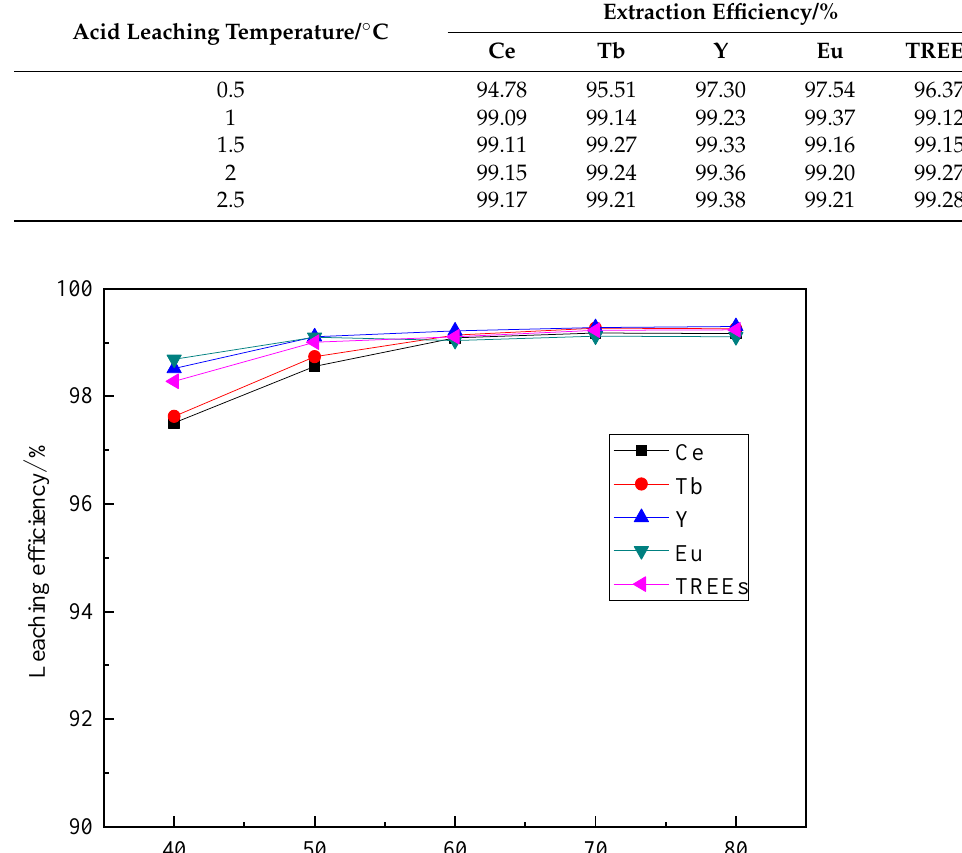
Table 7. Extraction efficiency of Ce, Tb, Y, Eu, and total rare earth under different acid leaching temperatures (oxygen concentration in the mixed gas of 0.4%, roasting temperature of 700 °C, roasting time of 2.5 h, mass ratio of phosphor powder to alkali 1:3, HCl solution concentration of 4 mol·L −1 , acid leaching time of 1 h, and liquid–solid ratio of 10:1). Acid Leaching Temperature/°C